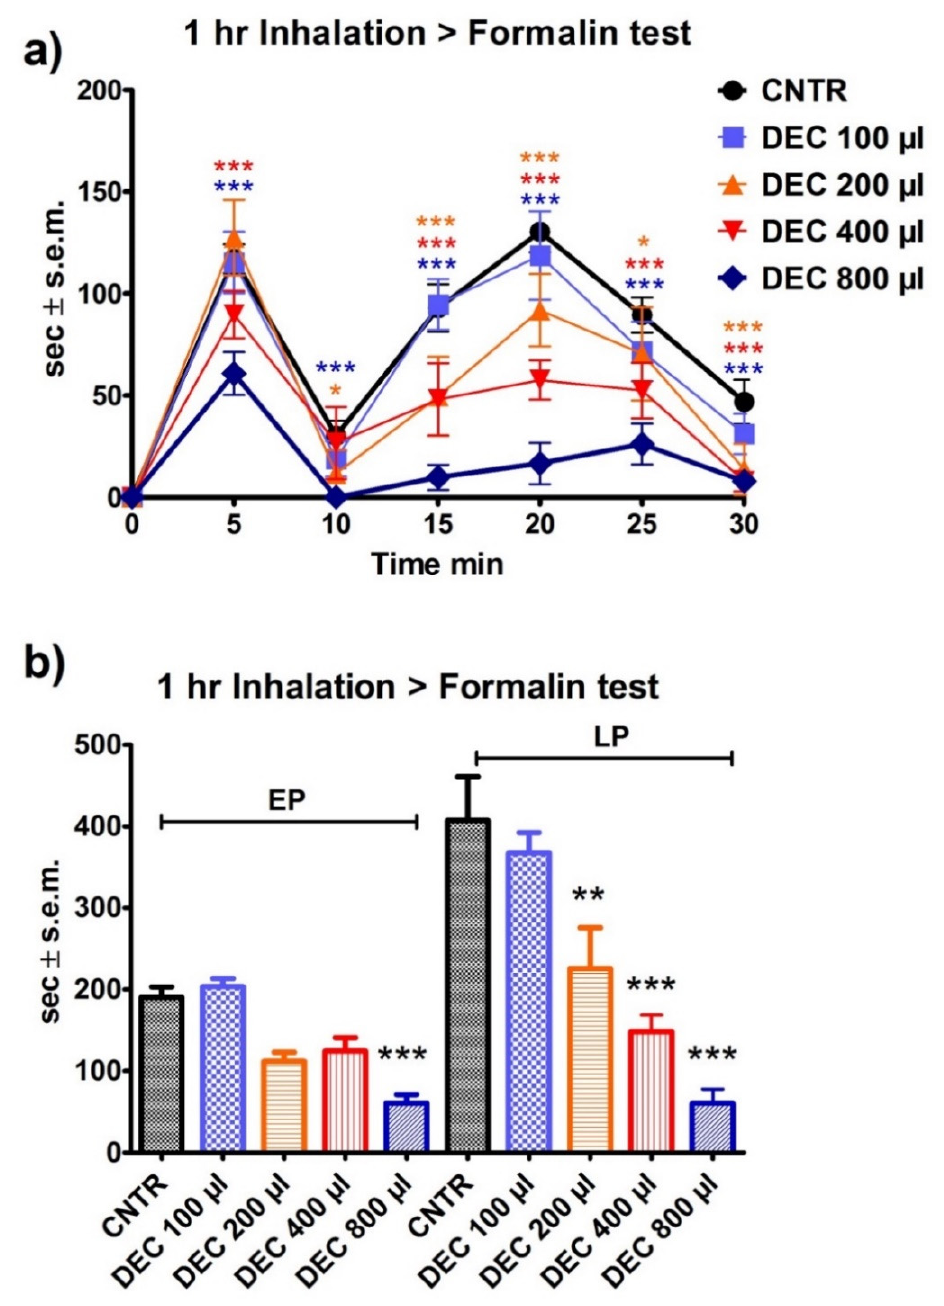
Figure 5. Effect of the one-hour pre-treatment with the decolored fraction (DEC) of bergamot essential oil (BEO) on 2% formalin-induced licking/biting behavior. ( a ) Time course based on seconds (sec) of licking/biting recorded at intervals of 5 min and expressed as time in sec ± S.E.M. ( b ) Overall licking/biting time expressed as time in sec ± S.E.M. during the first phase (EP, 0–10 min) and the second phase (LP, 10–30 min). Two-way ANOVA followed by Bonferroni test; n = 8, * p < 0.05, ** p < 0.01, *** p < 0.001.